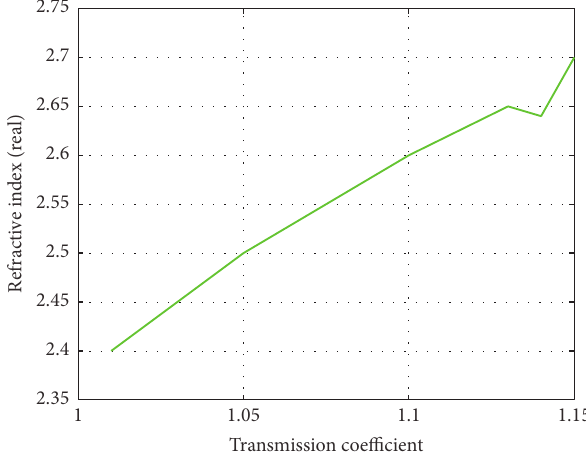
Figure 9: Plots for the real component of refractive index versus frequency for different radii ratio.